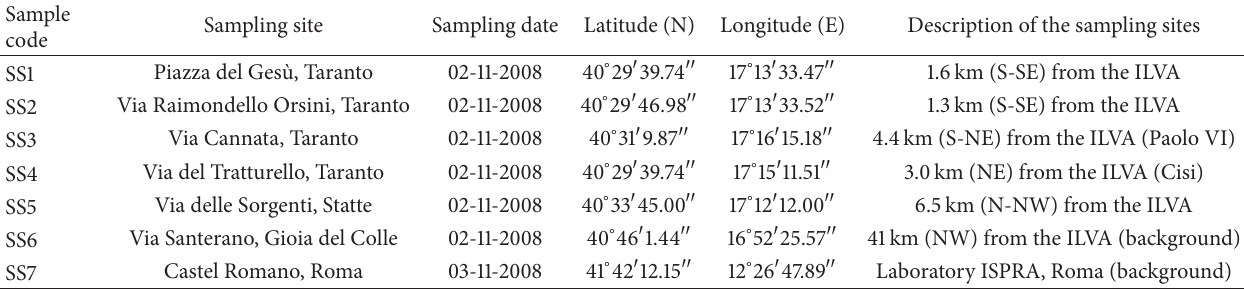
Table 4: Characteristics of the sampling sites for surficial soil (SS) samples (depth: 0–5